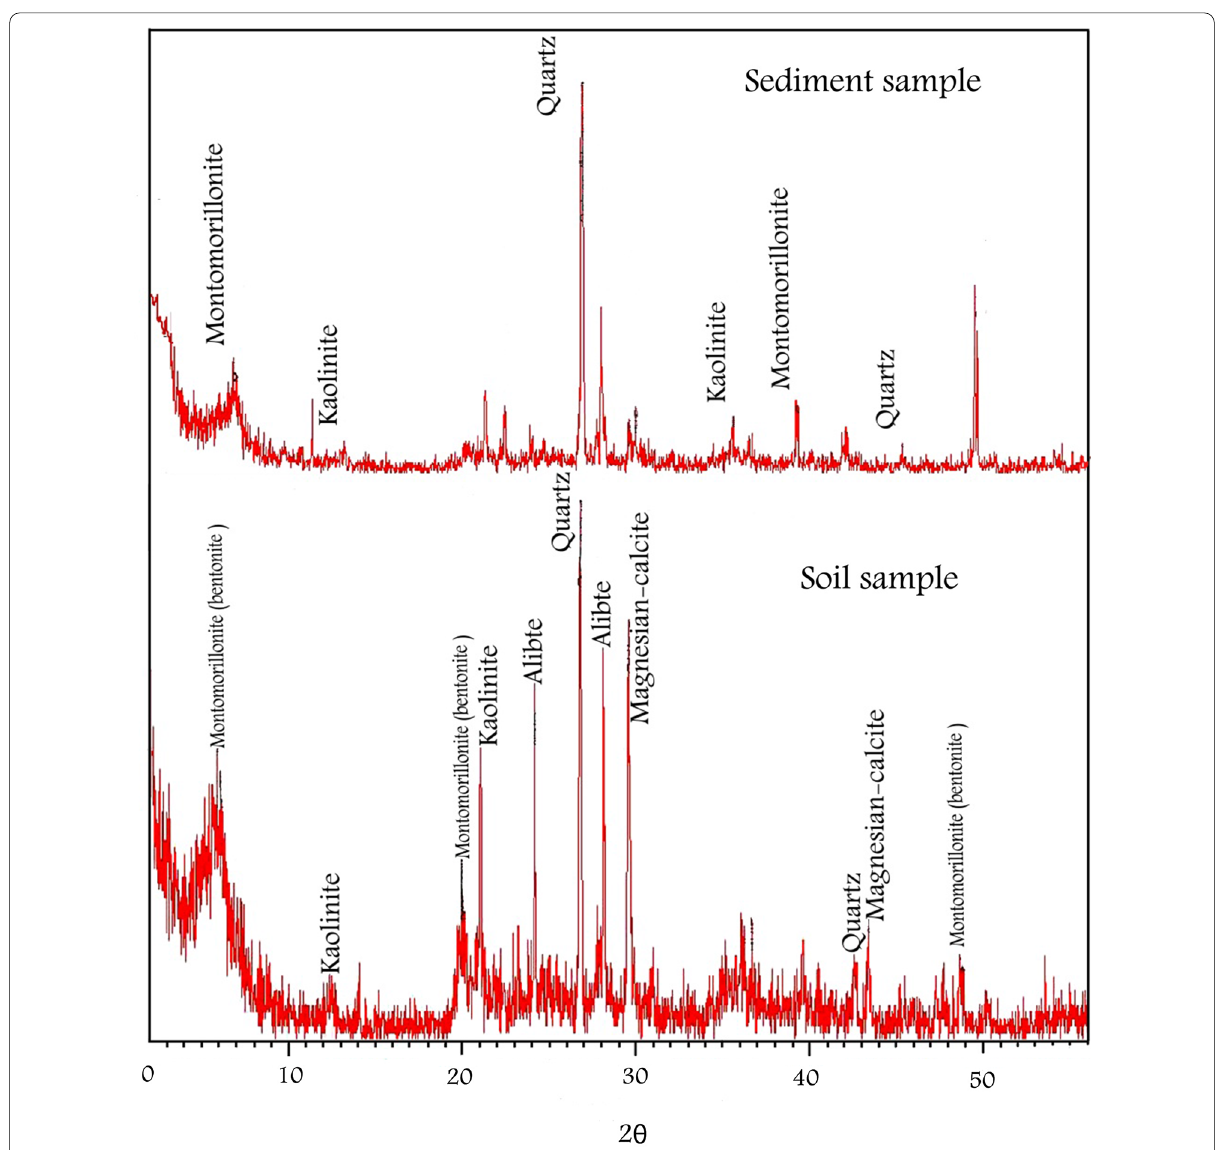
Fig. 2 X‑ray diffractograms for the soil and sediments of the studied